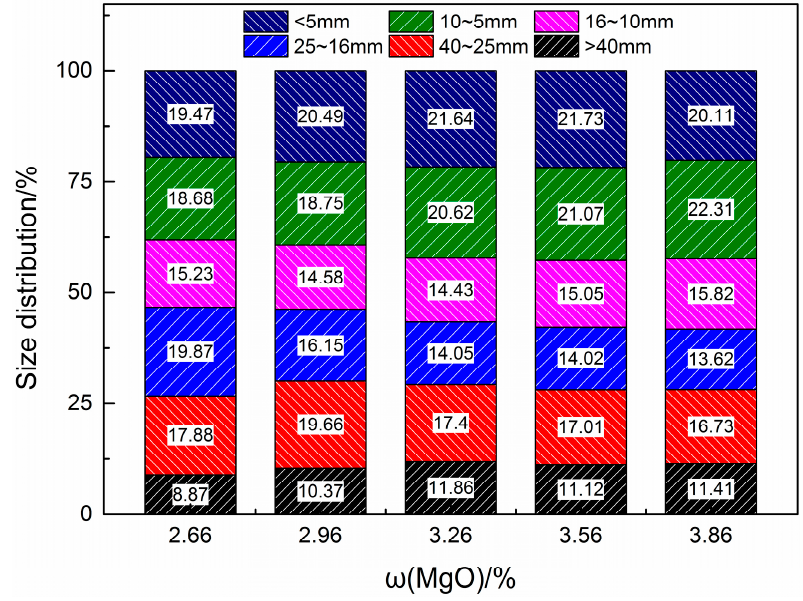
Figure 4. Particle size the distribution of CCVTM sinter with various MgO concentrations.